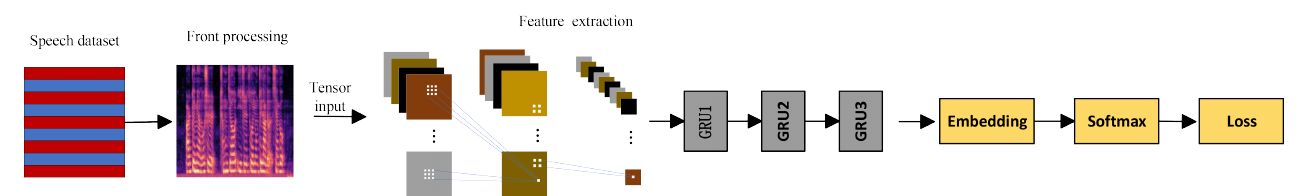
Figure 4. The structure of the deep GRU networks. The entire architecture diagram mainly includes voice signal preprocess- ing, two-dimensional convolutional layer, stacked GRU layers, a fully-connected layer, and softmax